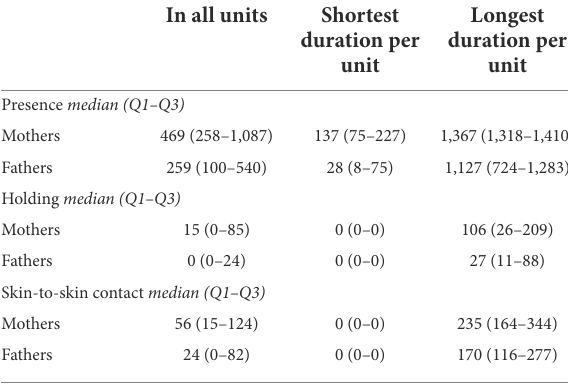
TABLE 1 The background characteristics of the families included in the final analysis.